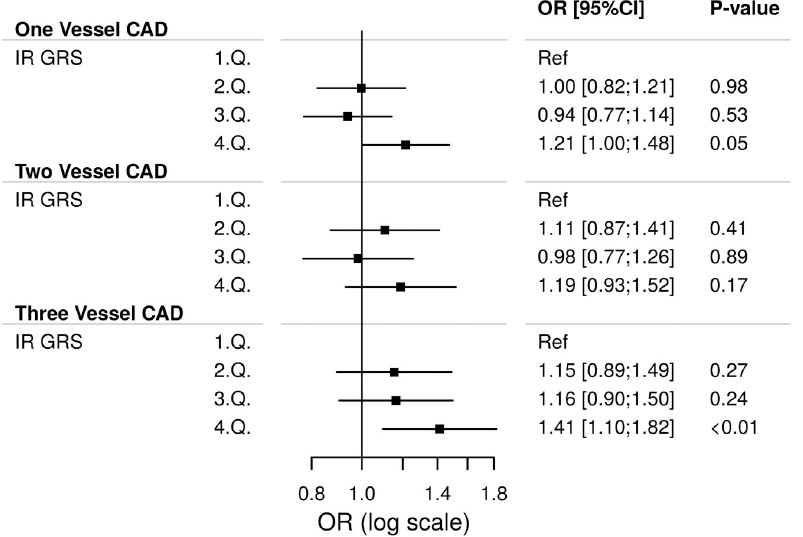
in relation to the insulin resistance GRS. A boxplot showing the distribution of the insulin resistance GRS according to number of coronary vessels affected can be found in S3 Fig in S1 File . A genetic predisposition to insulin resistance was associated with three-vessel coronary artery disease in the fourth quartile (4.Q) of the GRS by OR (adjusted) 1.41 (95% CI: 1.10, 1.82, p < 0.01, Fig 2 ). The detailed models including estimates of confounders for both coronary artery disease and disease burden of coronary artery disease (only three-vessel coronary artery disease shown) can be found in S4 and S5 Figs in S1 File, respectively. Similar results were found for the weighted GRS ( S6 Fig in S1 File ) and for the sensitivity analyses excluding patients with prior AMI. No effect modification was found within the GRS among patients